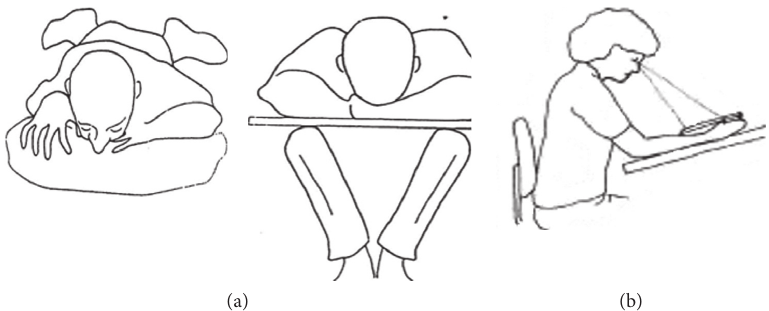
Figure 1: Drawing scheme showing the configuration of the two types of positioning recommended in the current study: (a) prone position; (b) nonsupine reading